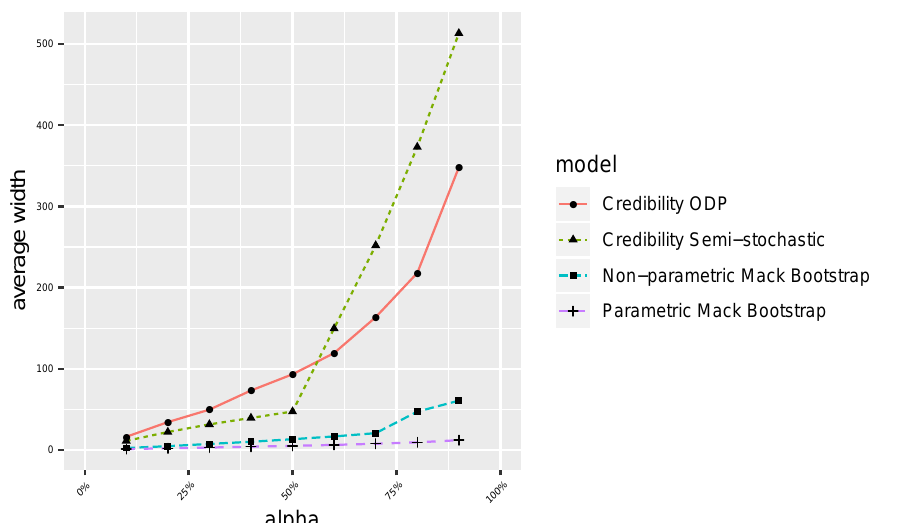
Figure 3. Average width values for 10% ≤ α ≤ 90% from all business lines.